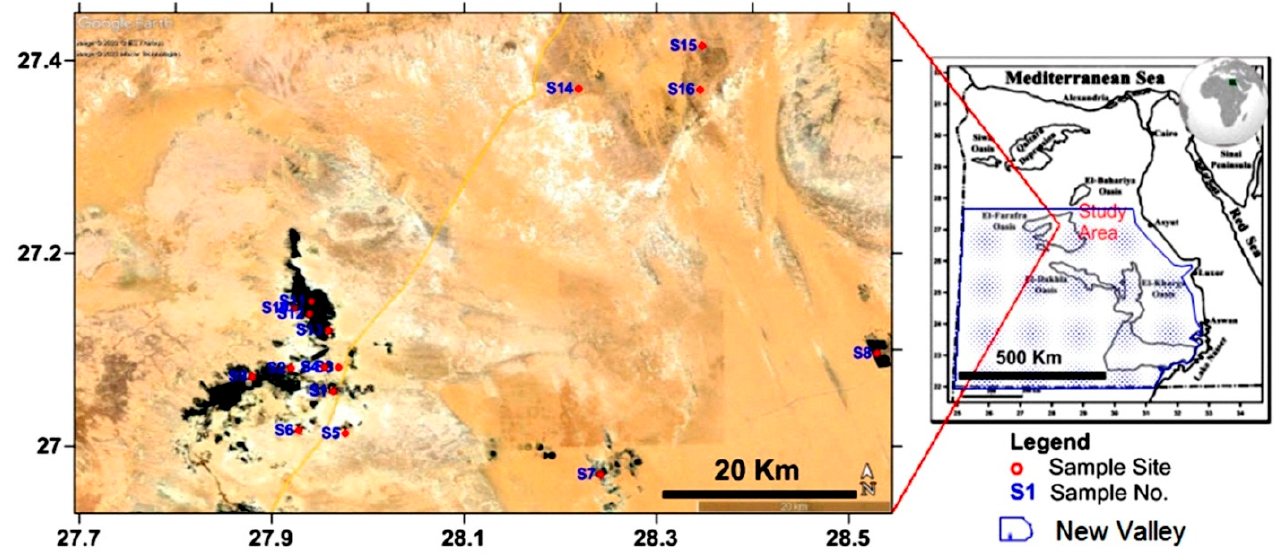
Figure 1. Location map of the study area and sampling sites.